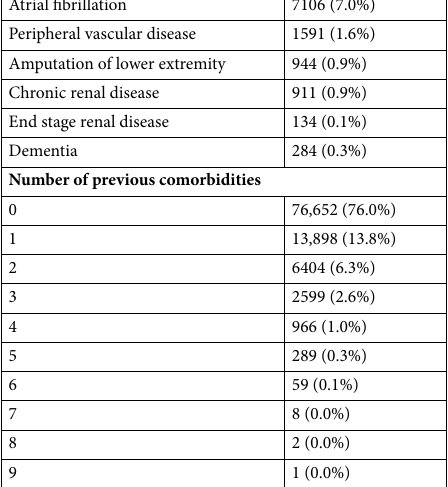
Table 1. Baseline characteristics. Data reported as n (%) or * mean (SD). eGFR estimated glomerular filtration rate, RoW rest of world, SEK Swedish krona.